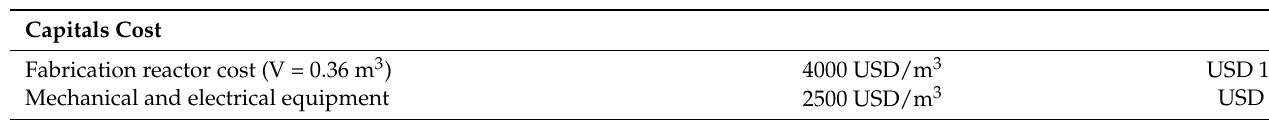
Table 6. Economic evaluation for the proposed Au/TiO 2 /Na 2 Ti 6 O 13 -based photocatalytic treatment